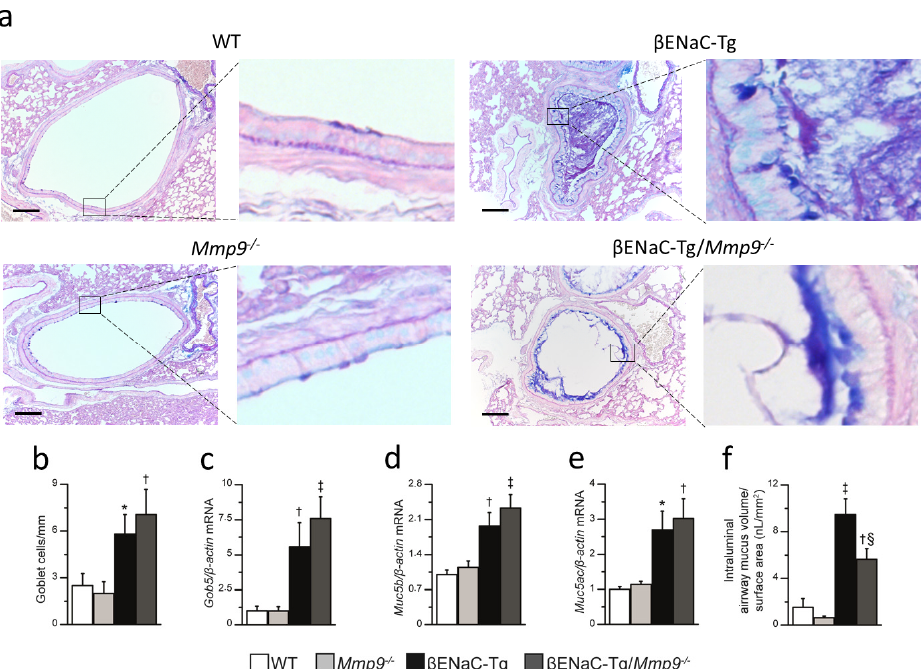
Figure 4. Genetic deletion of Mmp9 does not affect goblet cell metaplasia and increased mucin expression, but partially reduces airway mucus obstruction in β ENaC-Tg mice. ( a ) Representative sections of proximal main axial airway stained with alcian blue periodic acid-Schiff (AB-PAS) for assessment of goblet cell counts and airway mucus content in 6–8-week-old WT, Mmp9 -/- , β ENaC-Tg and β ENaC ‐ Tg/ Mmp9 ‐ / ‐ mice. Scale bar, 100 μ m. Insets (right side) show the airway epithelium, magnified from the original images using an 8× optical zoom. ( b – f ) Summary of goblet cell densities ( b ), mRNA expression levels of goblet cell marker Gob5 ( c ), mucins Muc5ac ( d ) and Muc5b ( e ), and intraluminal mucus content ( f ) in WT, Mmp9 ‐ / ‐ , β ENaC ‐ Tg and β ENaC ‐ Tg/ Mmp9 ‐ / ‐ mice. * p < 0.05 compared to WT or Mmp9 ‐ / ‐ , † p < 0.01 compared to WT or Mmp9 ‐ / ‐ , ‡ p < 0.001 compared to WT or Mmp9 ‐ / ‐ , § p < 0.01 compared to WT, Mmp9 ‐ / ‐ or β ENaC ‐ Tg/ Mmp9 ‐ / ‐ , n = 10–14 mice per group.